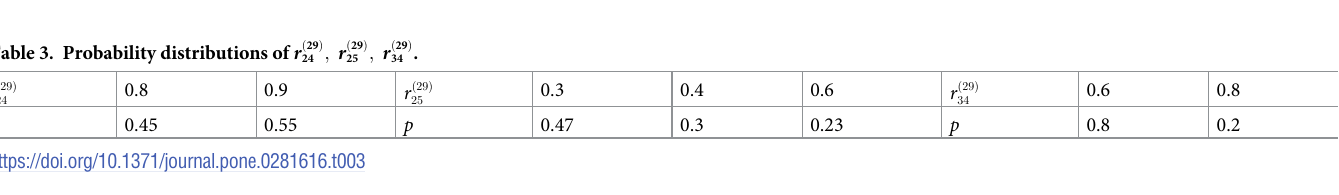
Table 3 below: H ð R ð 29 Þ Þ , which is the set of all possible matrices of the FCJM R (29) , contain 12 matrices, and the probability distribution of its consistency index CR is shown in Table 4 below: It can be known from Table 4 that the expected consistency index of R (29) is E ( CR ) = − 0.4403 < 0.1, which means the FCJM R (29) passes the consistency test. Therefore, the assess- ment results of the weights it has constructed are relevant. According to Es (10)-(13), we can obtain the linear and reciprocal weights of S follows (see Table 5). Thus, the weight vectors of S